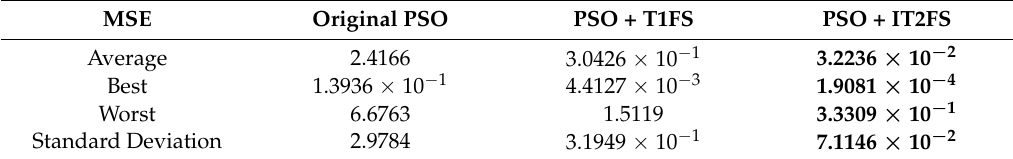
Table 10. Comparison of results from the plant without noise.